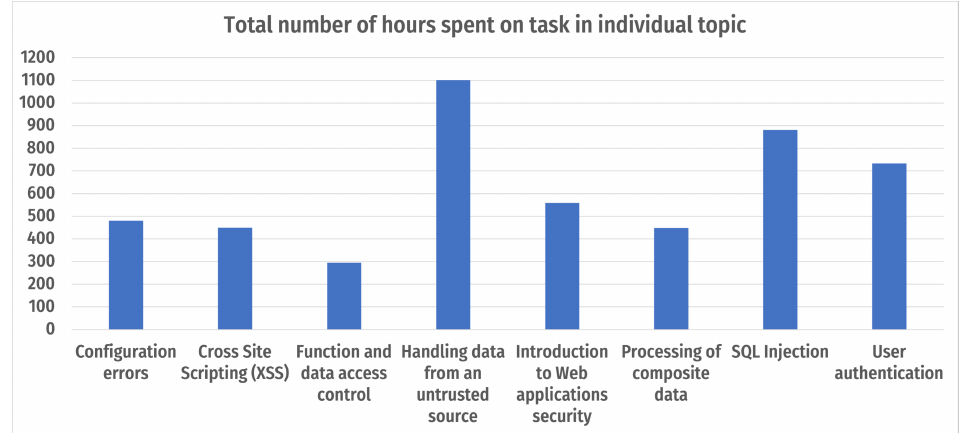
Figure 10. Number of hours spent on the exercises in the particular labs.